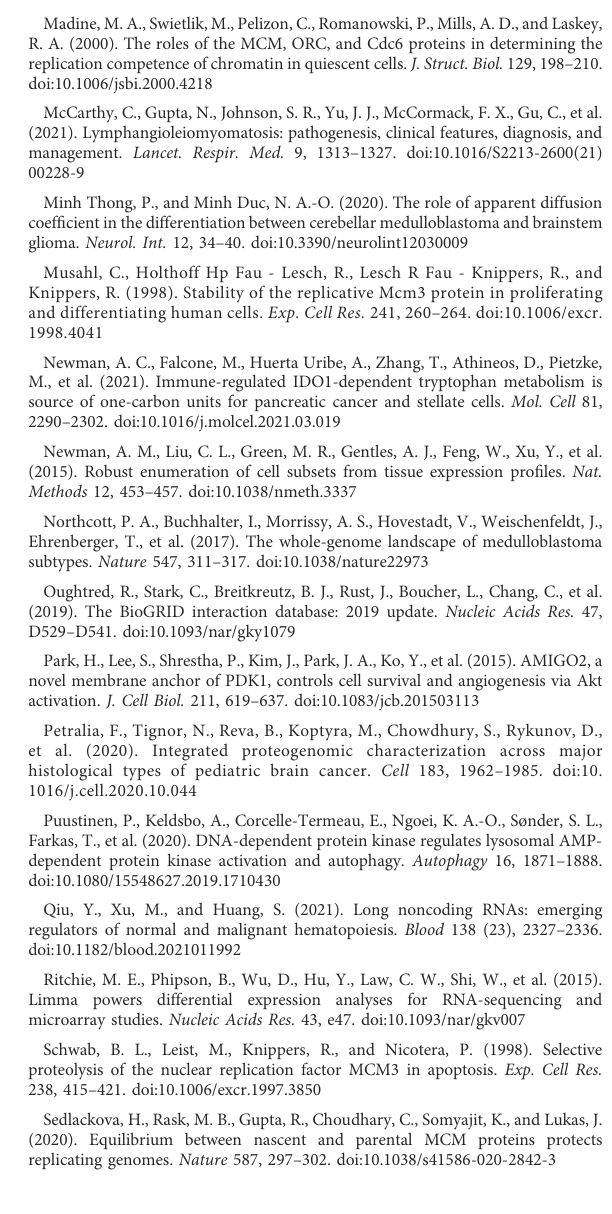
SUPPLEMENTARY FIGURE S3 Association of neutrophils with OS in the SHH subtype . Association of stromal score with OS in the SHH subtype (B) . Association of neutrophils with OS in WNT MB (C) . Association of stromal score with OS in the Group4 subtype (D) . Associations of estimate score with OS in Group4 MB (E) . Negative correlations of the expression of autophagy-related genes (DNM3, GABARAPL1 GABBR2, and OPTN) with MCM3 expression (F – I) . Relationship of the expression of autophagy-related genes (DNM3, GABBR2 and GABARAPL1) with OS (J – L) . SUPPLEMENTARY FIGURE S4 Lasso regression analysis with MCM3-correlated genes in GSE85217, in which17genesconstitutedthemulti-genesignature.Association ofthe risk score with OS in the internal validation set (C) . Association of the risk score with OS in our cohort (D)